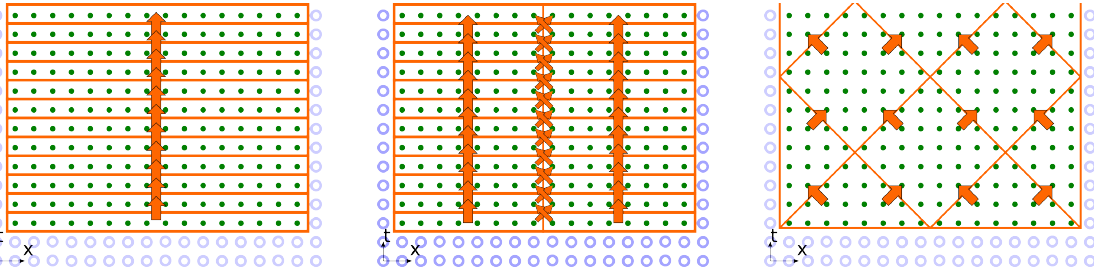
Figure 4. Algorithm as a rule of subdividing a dependency graph: stepwise ( left ), domain decomposition ( center ) and LRnLA example ( right ). Arrows show data dependencies between subdivision